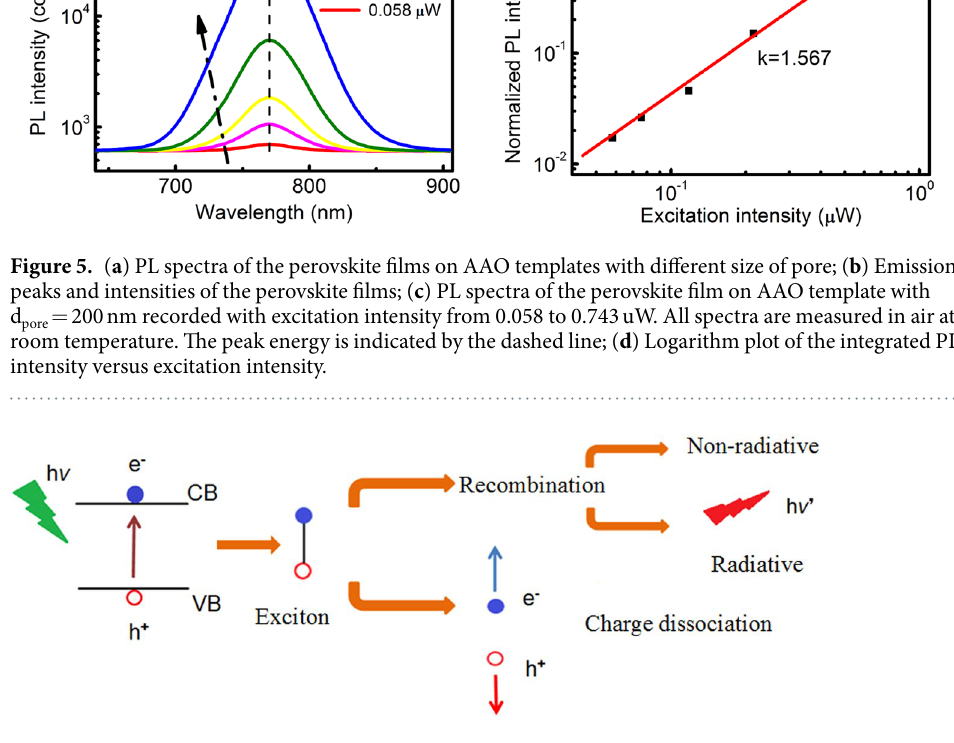
Figure 6. Schematic diagram based on the band theory shows that electron-hole pair has two opposite ways: charge dissociation or recombination (radiative and non-radiative